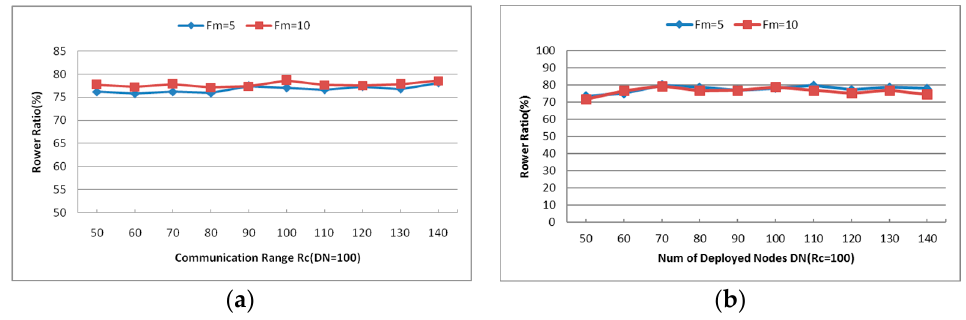
Figure 18. ( a ) PR with different (cid:1844) (cid:3030) and Fm; and ( b ) PR with different DN and Fm.